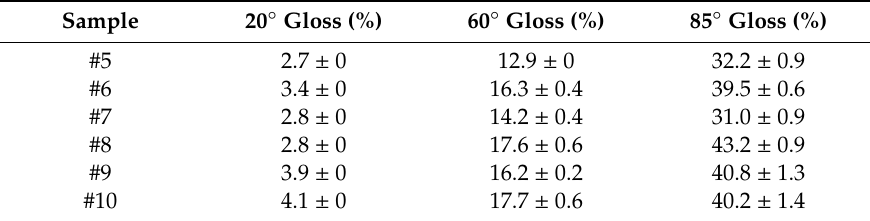
Figure 8. E ff ect of coating technologies on the color di ff erence between 18 and 40 ◦ C of waterborne Figure 8. Effect of coating technologies on the color difference between 18 and 40 °C of waterborne color-changing coating. color-changing coating. Table 9. E ff ect of coating technologies on the gloss of the reversible color-changing coating.